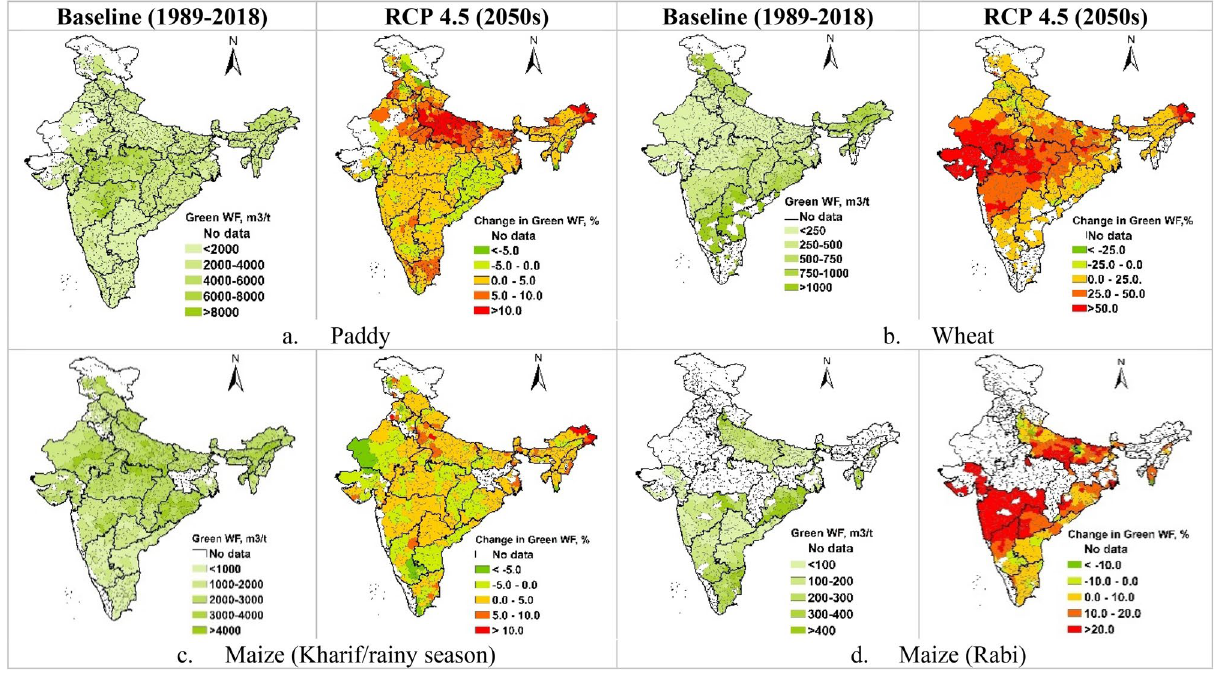
Figure 4. ( a–d ) Spatial variation in the green WF (m 3 /t) of crop production under baseline scenario (1989– 2018) and respective percentage variations under RCP4.5 2050s. These maps were generated using ArcGIS 10.8.1 (https:// www. arcgis. com/ index. of Uttar Pradesh, Bihar, Punjab and Haryana, while the increase in the central region would be in the range of 0.0–5.0% (Fig. 4a). Compared to paddy, wheat and kharif season maize have lower green WFs. Projections for 2050s showed that the green WF of wheat and rabi maize would increase over larger part of the country (Fig. 4b,d). In central regions and in the western part of the country, the increase in the green WF would be to the tune of 25.0% to > 50.0% and 10.0–20.0% in case of wheat and rabi/winter maize, respectively. Kharif season maize showed 0.0–5.0% decrease in green WFs in Chhattisgarh, Odisha, Andhra Pradesh, Karnataka and parts of Gujrat and Rajasthan. The regions with increase in green WF of kharif maize were similar to that of paddy, but the increase in green WF of kharif maize is comparatively smaller (0.0–5.0%) (Fig. 4c). The green WF of rabi maize is predicted to increase by 10–20% over the major maize growing states of Maharashtra, Karnataka, Telangana, and Uttar Pradesh, however along the eastern coastal areas the increase would be in the range of 0–10% (Fig. 4d). The regions with higher blue WF (500–2000 m 3 /t) are located in the north-western part of the country. With increase in rainfall and increased availability of green water for paddy during kharif/rainy season, there is a substantial decrease (0.0–50.0%) in blue WF in large number of paddy growing districts (Fig. 5a). Central and south-central regions of India have comparatively higher blue WFs (3000–6000 m 3 /t) of paddy mainly due to dryer winter seasons, and it is projected to increase by 5.0–10.0% over northern half of the country (Fig. 5b). Since the main source of water for rabi/winter maize is from irrigation, the blue WFs of rabi/winter maize was comparatively higher than that of kharif/rainy season maize (Fig. 5c,d). During 2050s, blue WFs of Kharif/rainy season maize is projected to increase by 25.0–50.0% or even > 50.0% over many kharif/rainy season maize grow- ing districts of India. Blue WF of rabi/winter maize was higher (1500–2000 m 3 /t) in the eastern Maharashtra and Odisha while in the major maize growing states (Uttar Pradesh and Bihar) the blue WF was in the range of 500–1500 m 3 /t. Increase in blue WFs is projected in the range of 5.0–10.0% in Uttar Pradesh and Bihar, and in the range of 0.0–5.0% over rest part of the country (Fig. 5d). The districts located in the northern parts of the country usually have lower blue WFs of rabi/winter crops due to occurrence of winter rains and lower tempera- tures during crop growth period, leading to reduced irrigation water use. WF of cereal production under climate change scenarios. The blue WF is important in the context of management of water resources. Analysis of the state wise variation in the blue WF of cereal production in ten major Indian states for reference scenario (1989–2018) revealed that five states, namely, Uttar Pradesh, Madhya Pradesh, Rajasthan, Punjab and Maharashtra accounts for about 51.3% of the total WF of cereal production in India (Fig. 6). Similarly, five states viz. Uttar Pradesh, Madhya Pradesh, Punjab, Haryana and Rajasthan share 70.7% of blue WF of cereal production in India. The blue WF of cereal production in Uttar Pradesh, Bihar and Tamil Nadu would decrease by 9.1, 9.9 and 5.3%, respectively under RCP4.5 during 2030s, while the increase in blue WFs of Karnataka, Madhya Pradesh and north western states (Punjab, Haryana, Rajasthan) would be in the range of 1.9–5.7%. Decrease in blue WF of Uttar Pradesh is encouraging as it would relieve the pressure on sur- face and ground water resources, however at national scale, it is counter balanced with the increased blue WFs